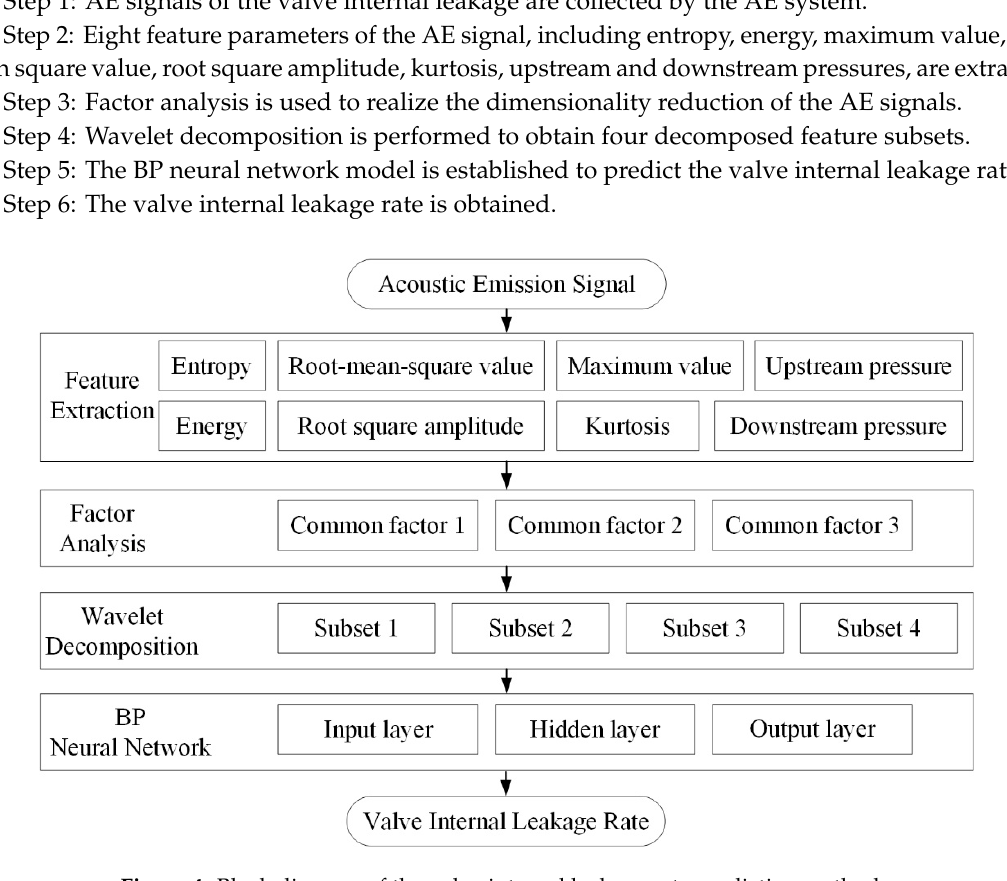
Figure 4. Block diagram of the valve internal leakage rate prediction method.